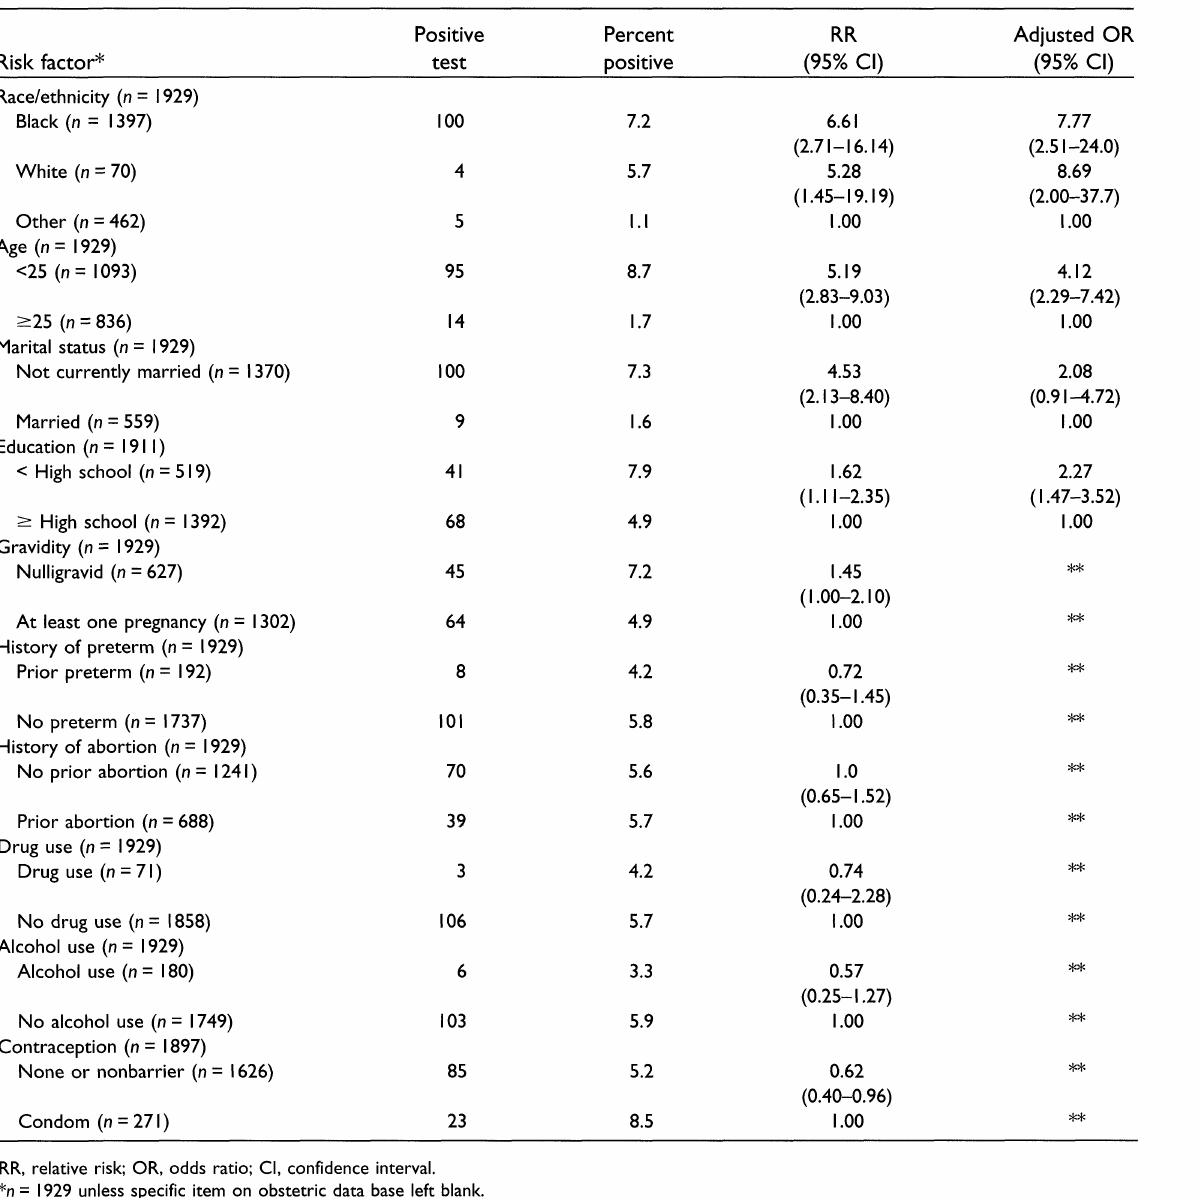
TABLE 2. Risk factors associated with a positive subsequent C. trachomatis test during pregnancy after a negative initial